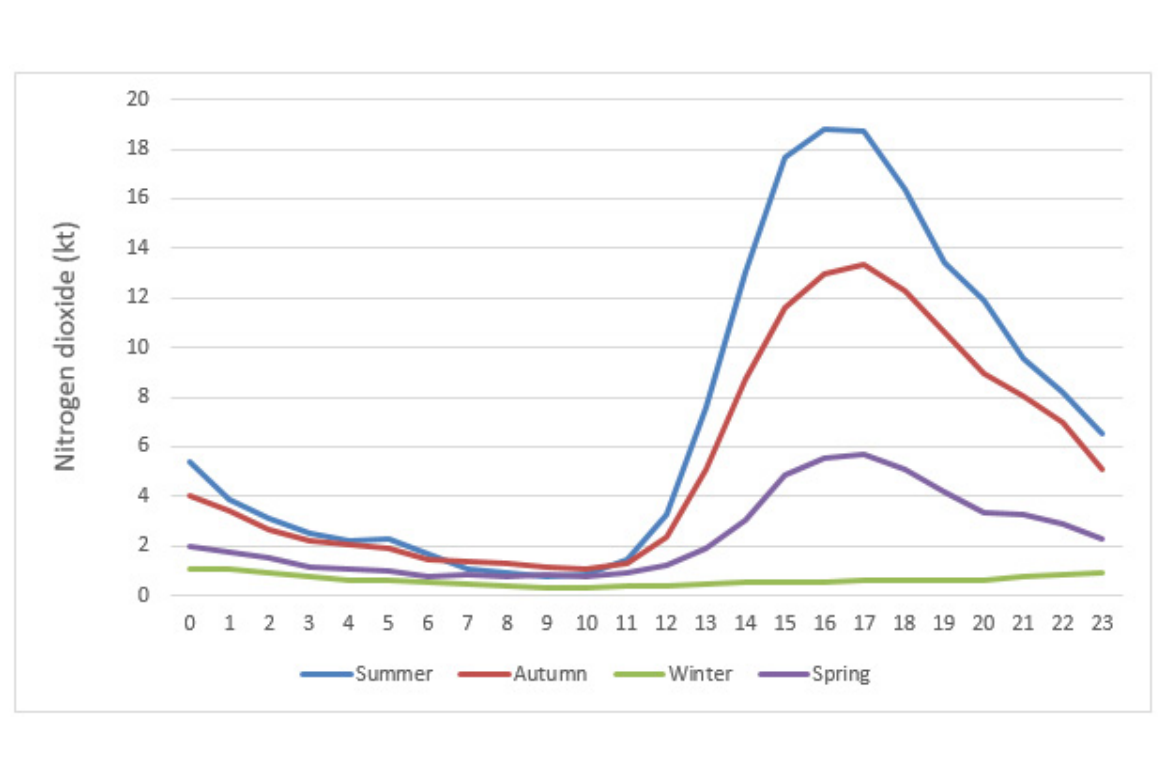
8 Volume 117| Number 9/10